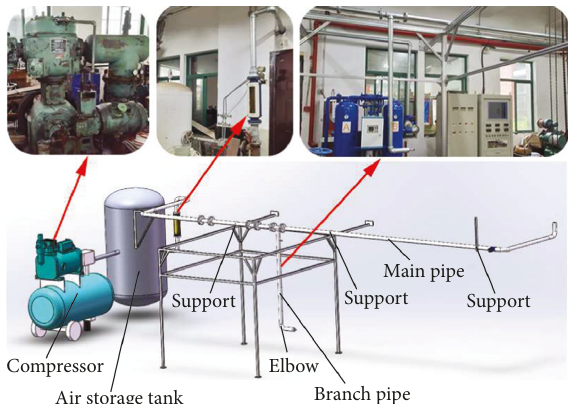
Figure 2: Experimental apparatus of pipeline